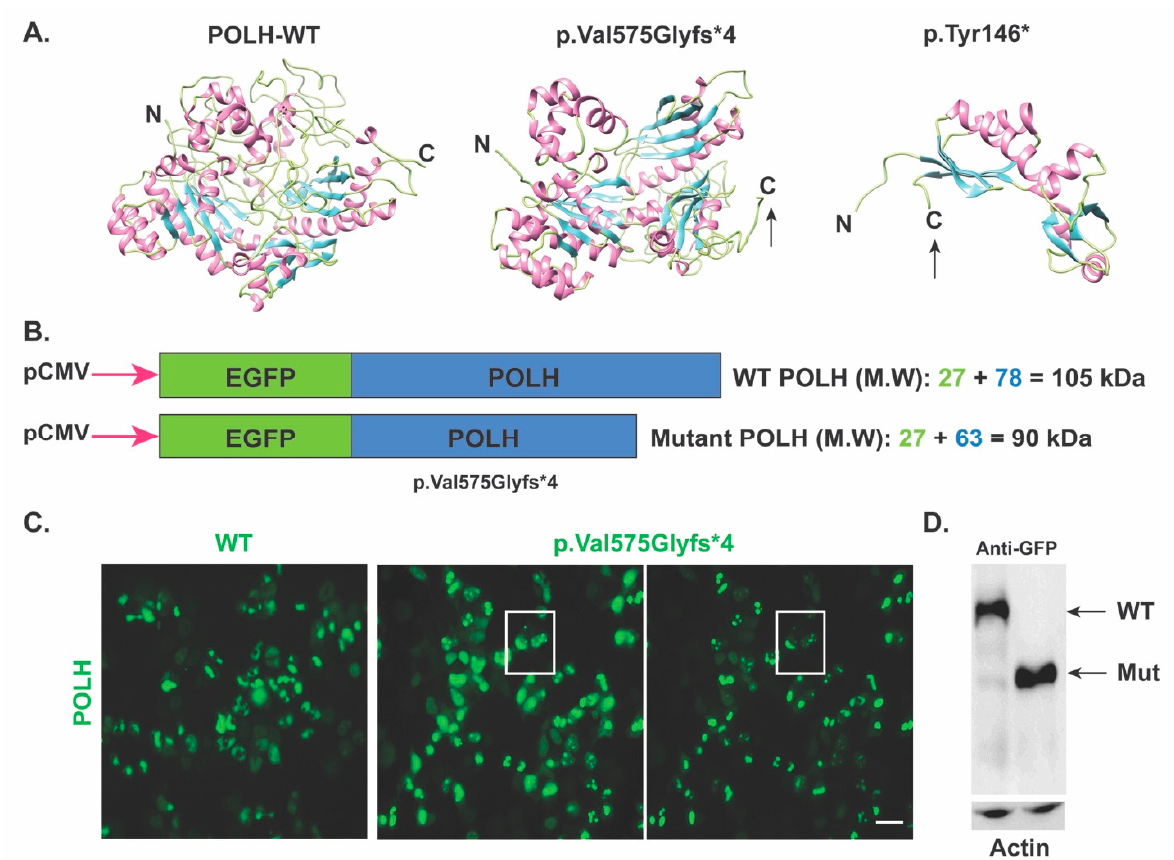
Figure 2. Wild type and mutant POLH expression in HEK293T cell lines. ( A ) POLH protein 3D structures. Protein helix, sheets and coils are shown in pink, blue and yellow colors, respectively. N and C terminals are labeled; however, truncation is marked by using arrow. ( B ) Graphical representation of POLH WT and mutant protein. Plasmid constructs were transfected in HEK293T cells. ( C ) Wild type and mutant POLH expression in HEK293T cell lines. The mutant (p.Val575Glyfs*4) protein displayed punctate expression in cells. ( D ) Western blot image of POLH WT and mutant protein using GFP and POLH antibody.